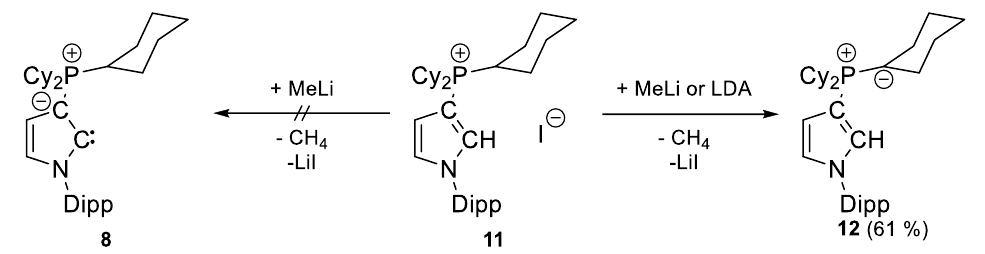
Figure 4. Molecular structures of (left) 11 and (right) 12 . Ellipsoids are drawn at the 50% probability level. Selected bond lengths are provided in Table